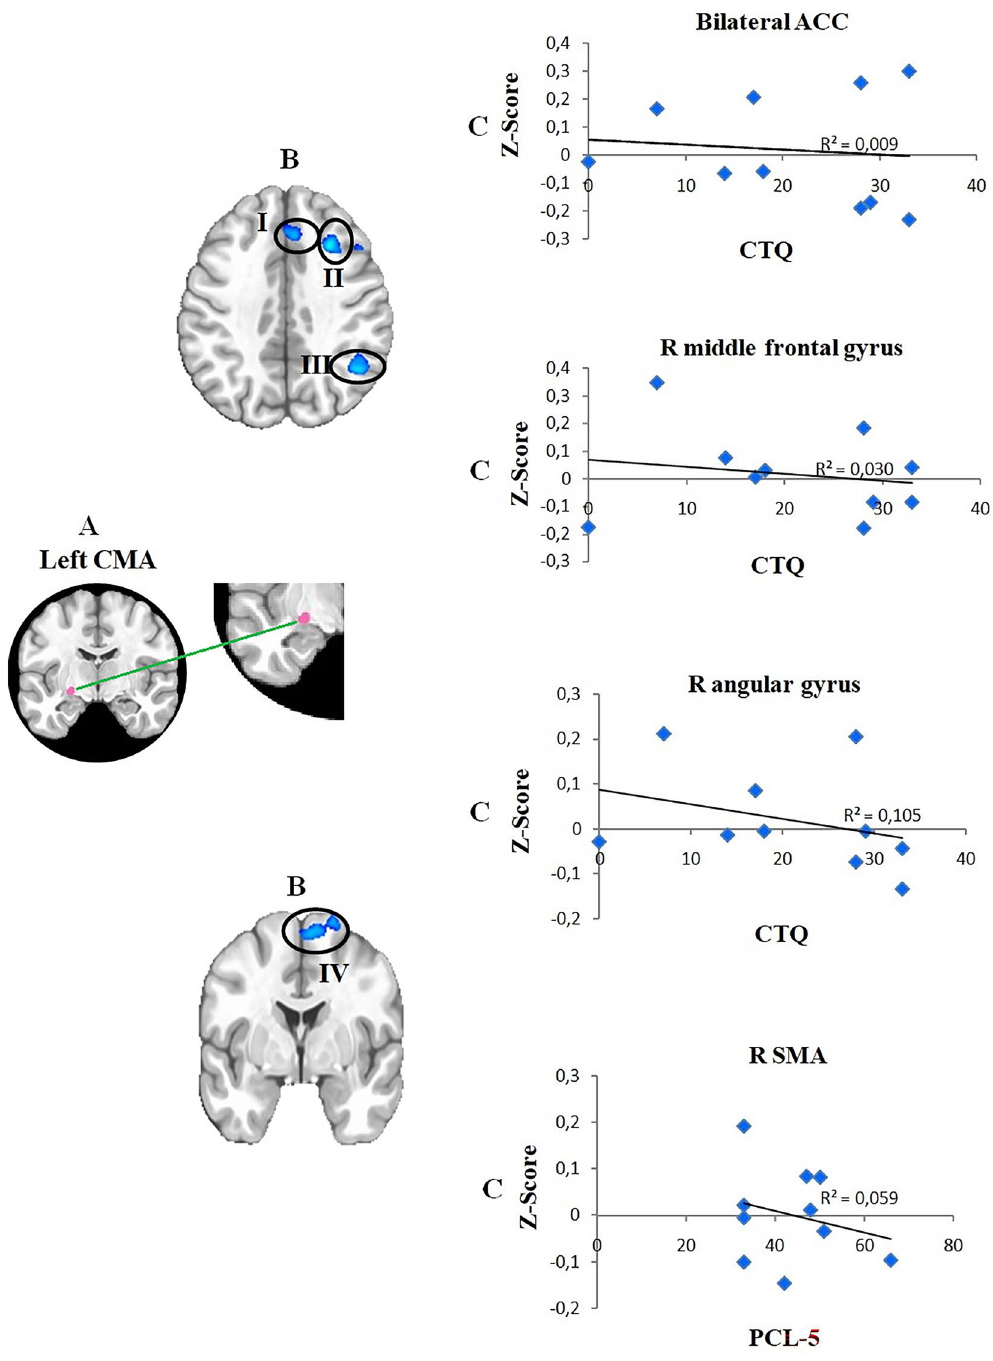
Figure 2. Areas of negative correlation between functional connectivity for left CMA and CTQ in the PTSD group. ( A ) Illustration of seeds, filled in pink (seed is magnified for better visualization); ( B ) overlays for the areas of the brain that showed significant association for the CMA, for PTSD CTQ scores (p < 0.05 corrected for multiple comparisons); ( C ) the scatter plots on the right show the relationship between the connectivity scores for the CMA and the associated regions. I = Bilateral anterior cingulate cortex (ACC); II = Right middle frontal gyrus. III = Right angular gyrus; IV = Right supplementary motor area (SMA); R right, L left, CTQ Childhood Trauma Questionnaire—total score, PCL-5 Posttraumatic Checklist-5—total